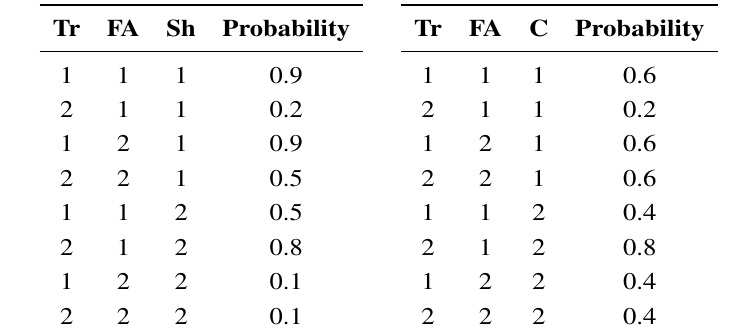
Table 3. Conditional probabilities, including